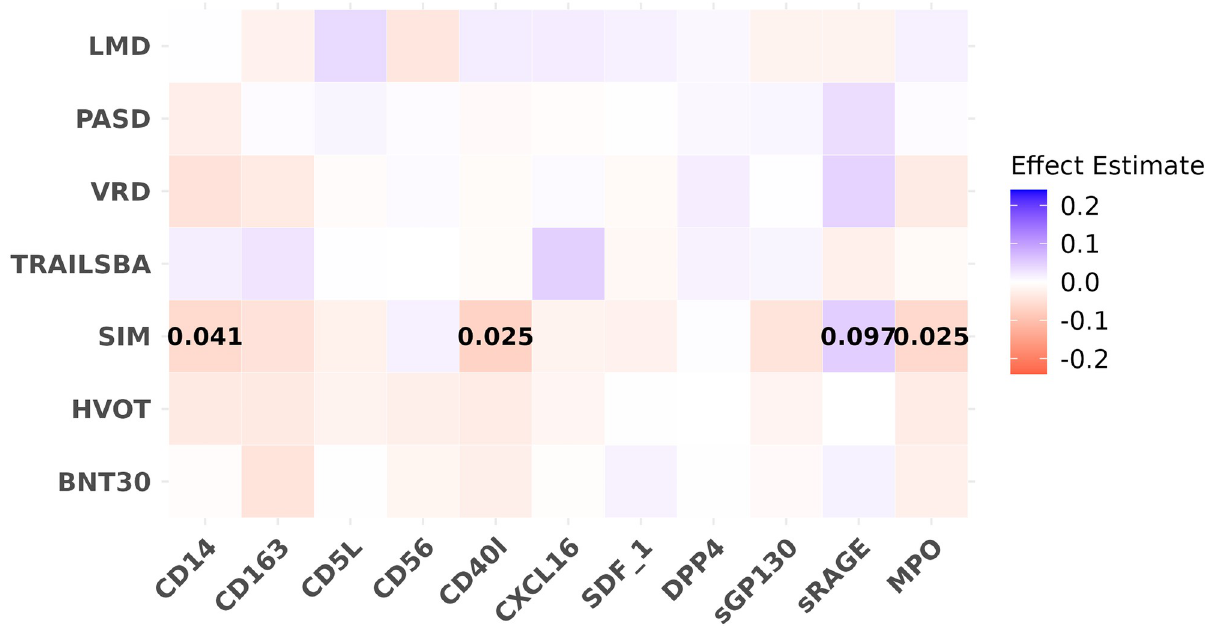
Fig 2. Effect estimates and FDR value for the associations of protein biomarkers with neuropsychological testing scores. Effect estimates are in colors and FDR value (if � 0.1) are labeled as numbers. Both protein biomarker predictors and cognitive outcomes were rank normalized to mean 0 and SD 1. Each color block shows the estimated effect for each pair of associations investigated in the primary analyses using linear mixed effect models adjusting for the covariates from Model 1(age, sex, education level, time distance between exam 7 and the neuropsychological testing, and retest indicator). FDR are shown for associations where FDR �